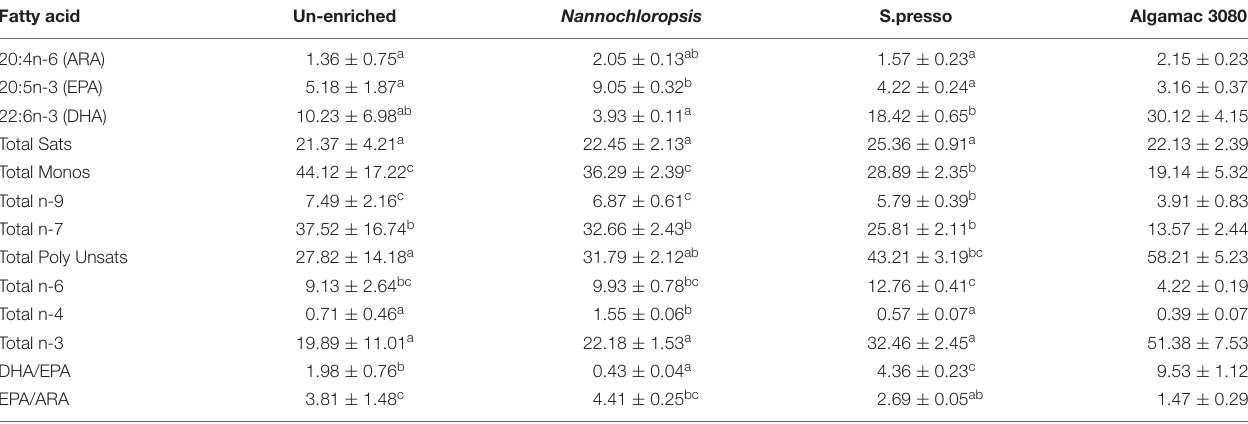
TABLE 2 | Fatty acid composition (% of total fatty acids) of rotifers.